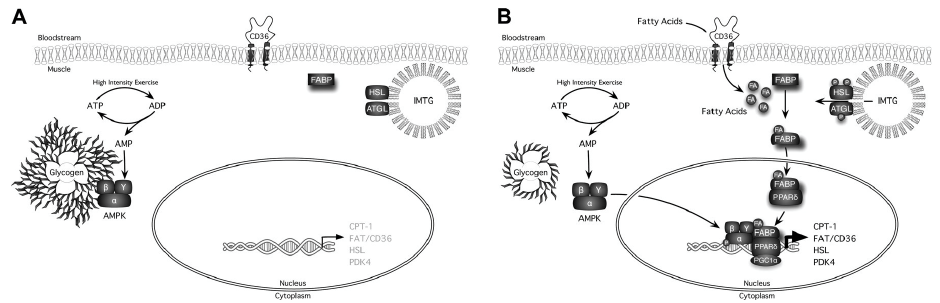
Figure 6. Graphic representation of some of the signaling events that are differentially activated by exercise in either a high ‐ glycogen ( A ) or low ‐ glycogen state ( B ) [56]. FA; fatty acid, PDK4; pyruvate dehydrogenase kinase 4, ATGL; adipose triglyceride lipase, IMTG; intramuscular triglyceride, FABP; FA ‐ binding protein, PPAR; proliferator ‐ activated receptor, PGC ‐ 1 α ; PPAR γ coactivator ‐ 1 α .